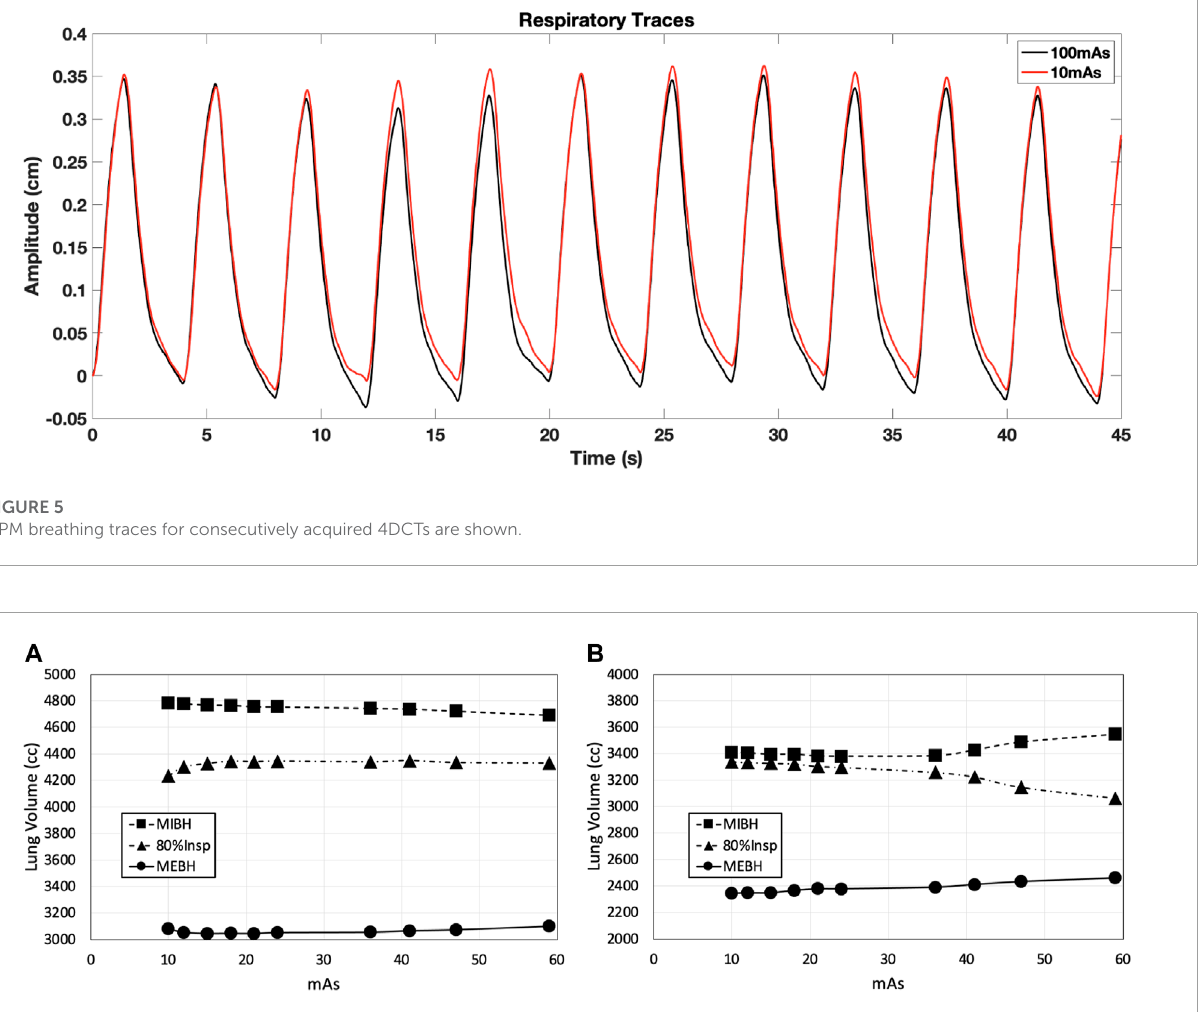
FIGURE 6 BHCT volume control is shown through two examples. In panel (A) , volumes remained relatively consistent across all ten scans of all three volumes. In panel (B) , clear volume drift is seen across scans. Scans were always acquired in decreasing 59–10 mAs order, so volume drift typically had a larger impact on comparisons involving low mAs